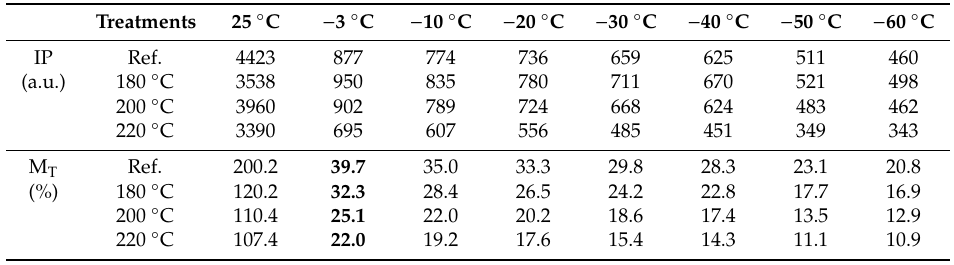
Table 4. The integral of the peaks (IP) and content of unfrozen water (M T ) of Douglas fir at di ff erent temperatures.